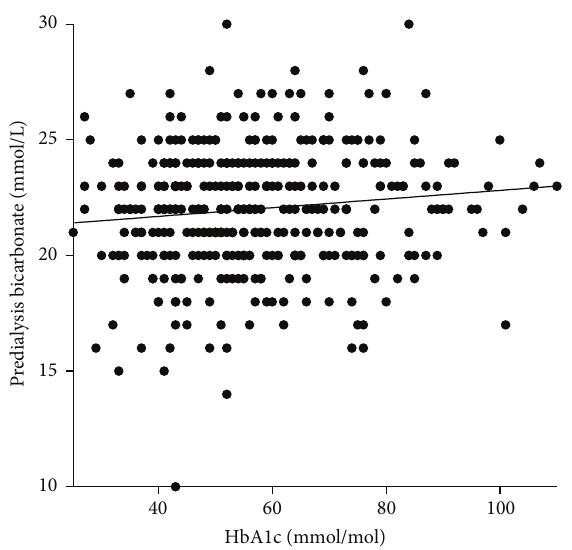
Figure 4: Correlation between glycaemic control and predialysis